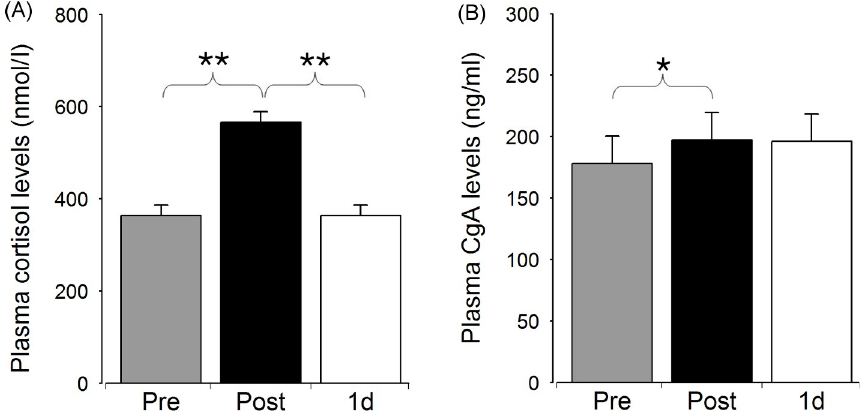
Fig 2. Plasma levels of the stress markers directly before (Pre), directly after stenting (Post), and on the next day following PCI (1d). Data are presented as mean ± SE, n = 23. Significant differences for cortisol: Pre/Post and Post/1d - p �� < 0.01; for chromogranin A (CgA): Pre/Post—p � < 0.05.